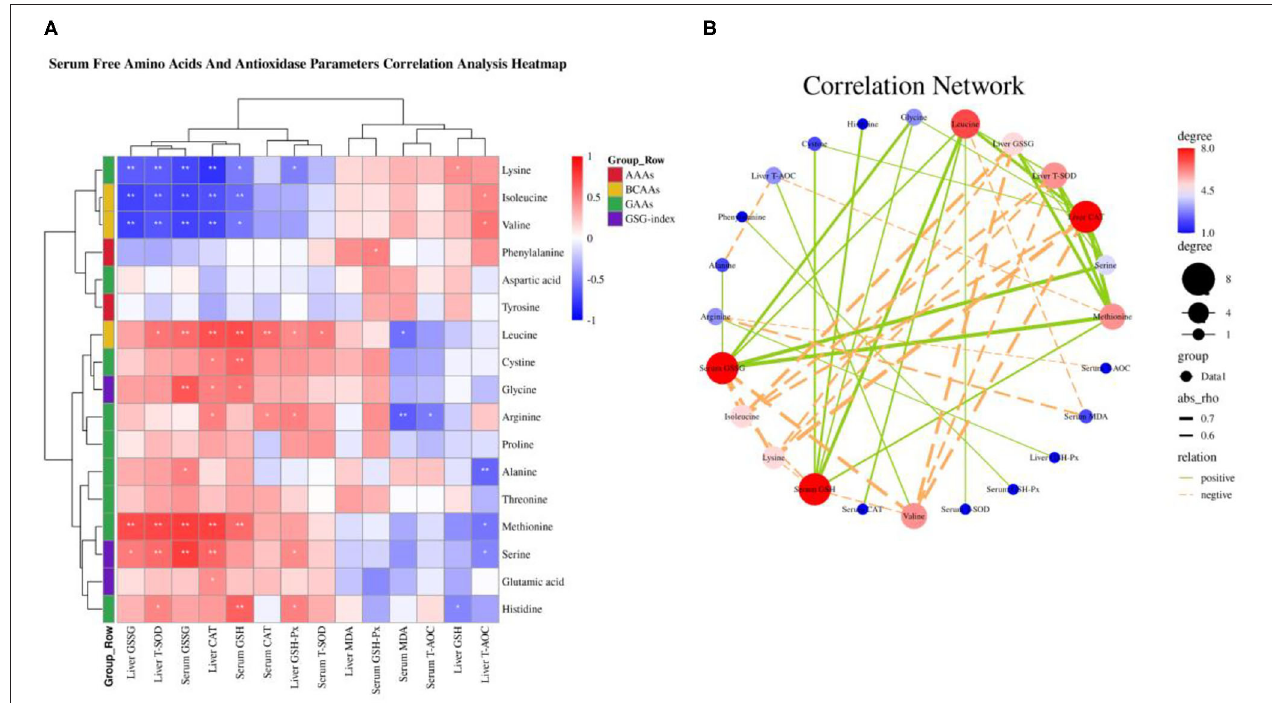
FIGURE 7 | Serum-free amino acids and anti-oxidase parameters correlation analysis. (A) Serum-free amino acids and anti-oxidase parameters correlation analysis heatmap. (B) Correlation network. * P < 0.05 and ** P <